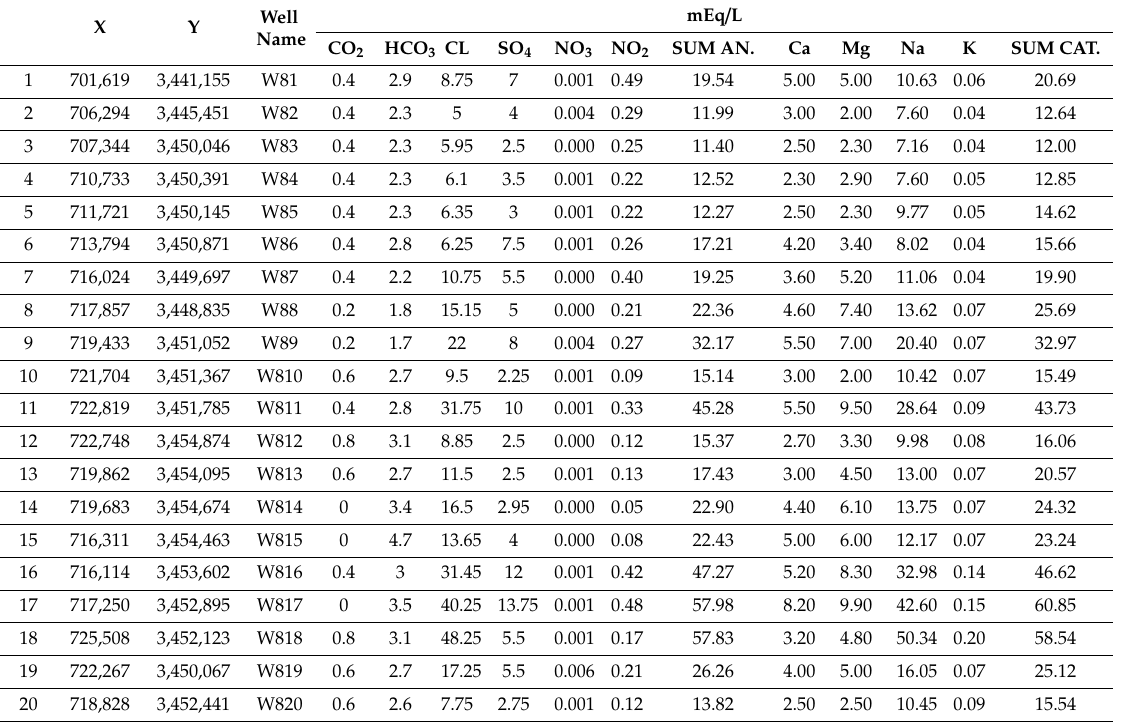
Figure 15. Contour lines of the nitrite concentrations in groundwater in mg/L in the Abarkooh plain. Tables 1 and 2, show the chemical analysis of all other chemical parameters for the selected wells in the Abarkooh plain [23]. Table 1. Chemical analysis of selected wells in the Abarkooh plain.